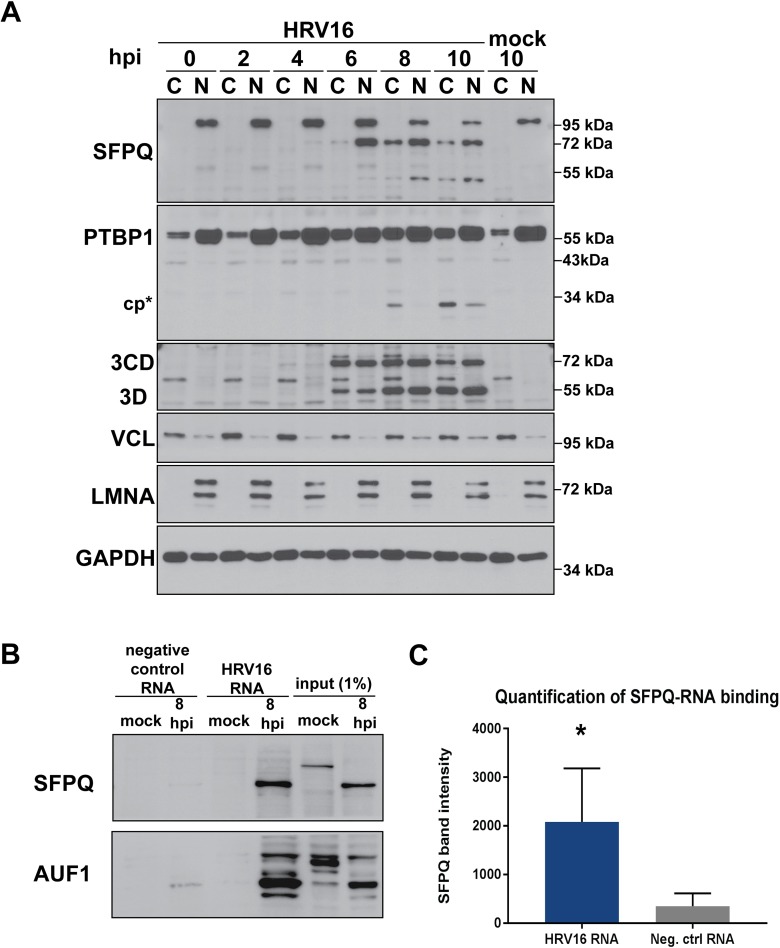
An SFPQ cleavage product associates with in vitro transcribed HRV16 RNA.(A) HeLa cells were mock- or HRV16 infected, fractionated at 2 h intervals, and the subcellular distribution of proteins was analyzed by Western blot. The cleavage product (cp*) of polypyrimidine tract binding protein 1 (PTBP1) is indicated and HRV16 3D and its precursor 3CD served as markers of infection. VCL and LMNA served as markers for the cytoplasm (C), nucleus (N); GAPDH was used as a general loading control. (B) Biotinylated, in vitro transcribed control or HRV16 RNA were assayed for binding to cellular proteins present in HeLa cell lysates following mock infection or 8 hours post-infection (hpi) with HRV16 by Western blot analysis. A representative experiment is shown. (C) Quantification of four separate RNA affinity experiments was carried out using Quantity One software. Means are shown and error bars represent standard deviations (* P < 0.05).